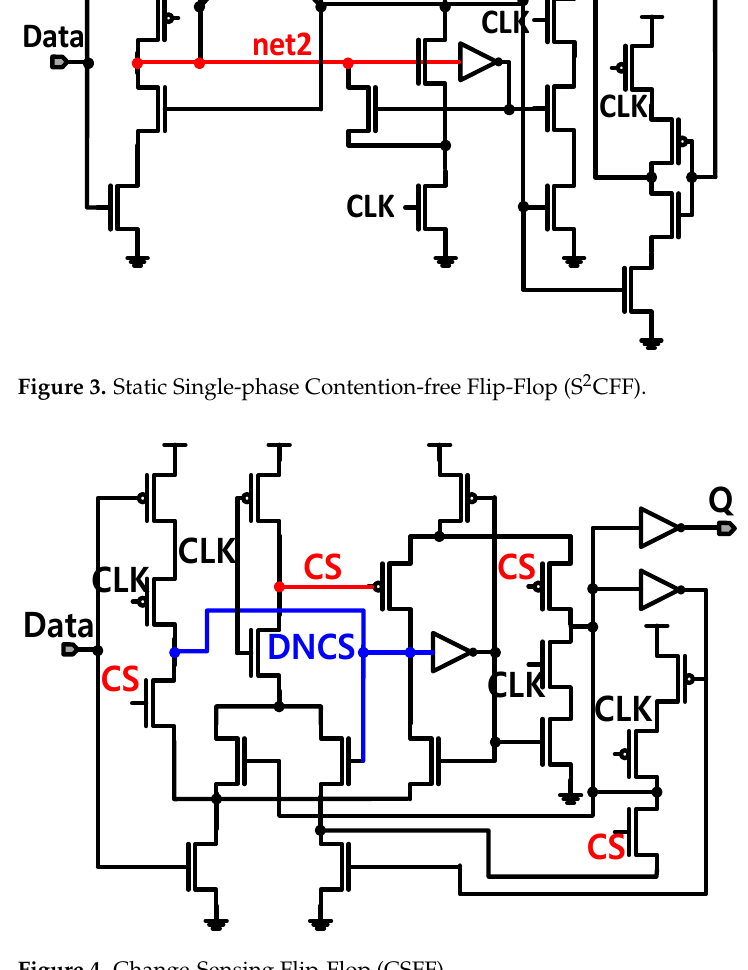
Figure 4. Change-Sensing Flip-Flop (CSFF).